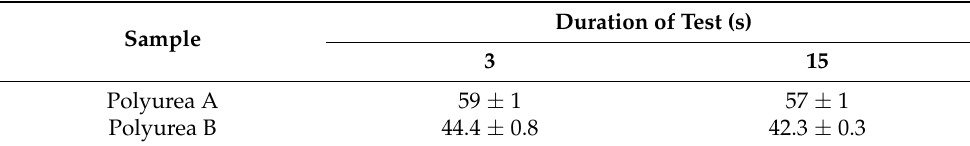
Table 3. Shore D hardness test results.